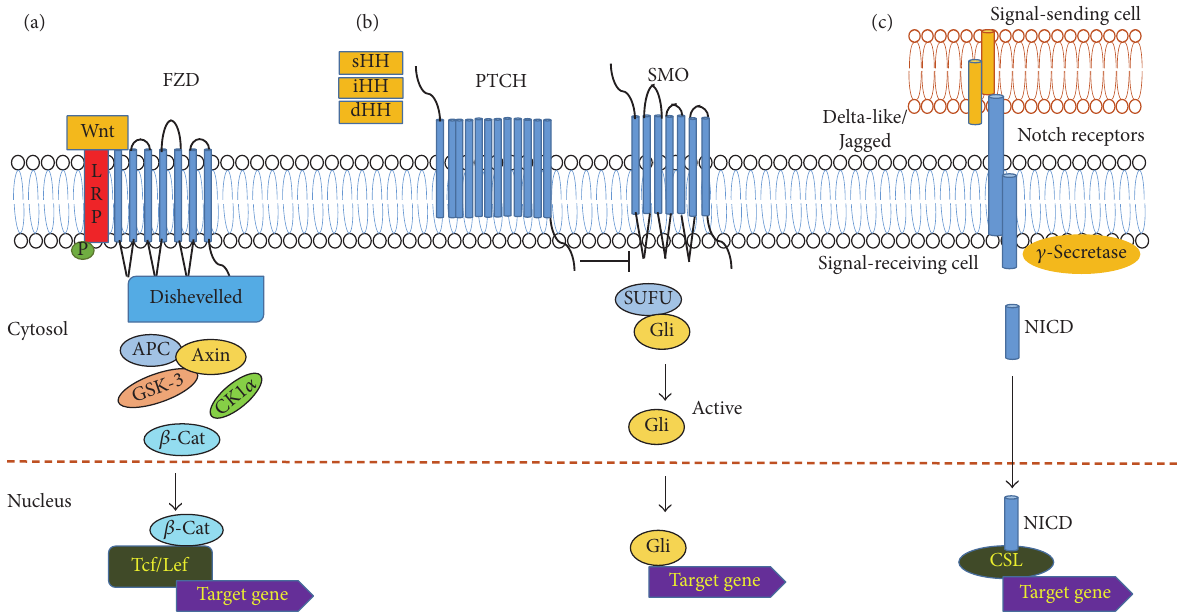
Figure 2: Wnt, Hedgehog, and Notch canonical signaling pathways. (a) In the canonical Wnt signaling pathway, when Wnt ligand binds to FZD and LRP receptors, the 𝛽 -catenin destruction complex (Axin, GSK3, APC, and CK1) is decomposed, and active 𝛽 -catenin accumulates and translocates to the nucleus for target gene transcription. (b) In the canonical Hedgehog pathway, when ligand binds to PTCH, the inhibitory effect of PTCH to SMO is removed. Subsequently GLI is activated and translocates into nucleus for target gene transcription. (c) In the canonical Notch pathway, delta-like or Jagged ligand binds to Notch receptor and a series of extracellular and intracellular cleavages